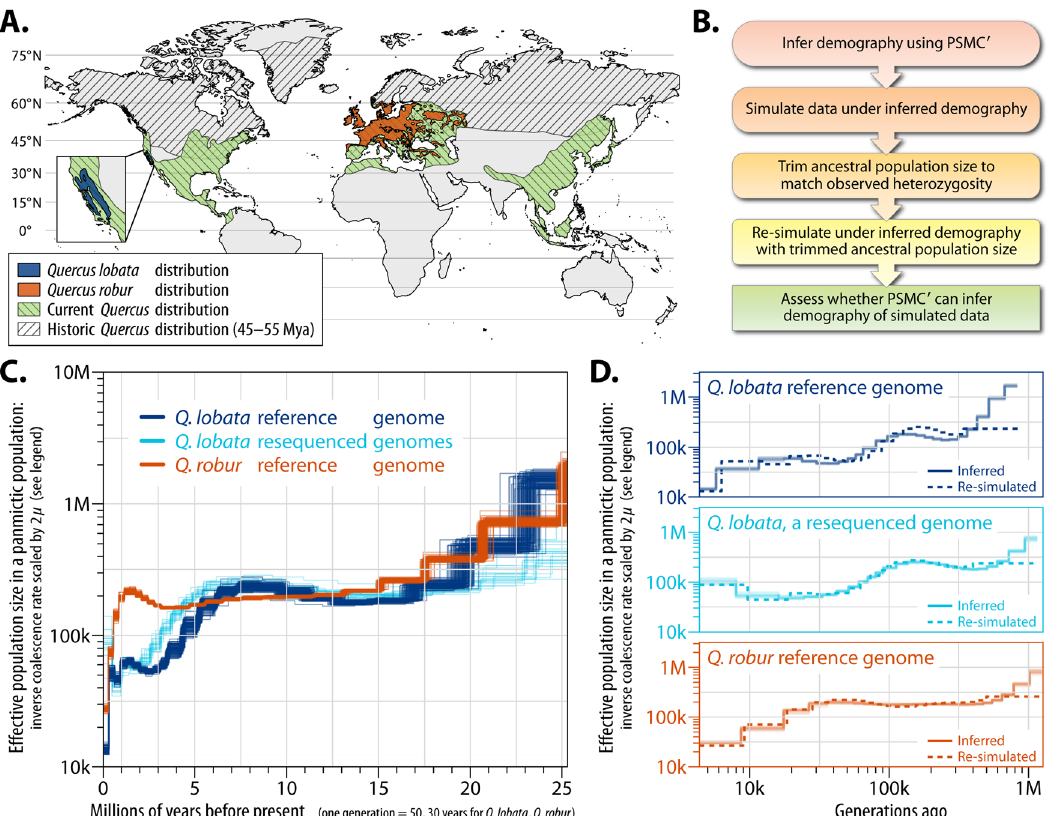
Fig. 2 Demographic evolutionary history analysis of Q. lobata and Q. robur . A Historic and contemporary species ranges based on Barrón, Averyanova 3 and fossil occurrence records from the Global Biodiversity Information Facility website (https://www.gbif.org/, 19 January 2019). Contemporary distribution of Q. robur is from the European Forest Genetic Resources Programme http://www.euforgen.org/species/quercus-robur/); Q. lobata is based on Grif fi n and Critch fi eld 91 . All data and map information are in the public domain. Land boundaries were obtained from NaturalEarthData.com (https:// www.naturalearthdata.com/about/terms-of-use/). Quercus spp . records used to reconstruct the historic distribution were obtained from GBIF (GBIF.org, 19 January 2019, GBIF Occurrence Download). The current distribution of Q. robur was from EUFORGEN (http://www.euforgen.org/species/quercus-robur/). Occurrence records used to create the current distribution of Quercus and Quercus lobata were obtained from GBIF (GBIF.org, 22 January 2019, GBIF Occurrence Download)). B Stages of the analysis. C Inferred effective population sizes over time via PSMC ′ (100 bootstraps shown per condition), using a mutation rate of 1.01×10 – 8 bp per generation (see Supplementary Note 4. Demographic analysis, and Supplementary Fig. 6 for other parameters). D PSMC ′ accurately infers demography (solid) on data simulated (dashed) under models fi t to the empirical